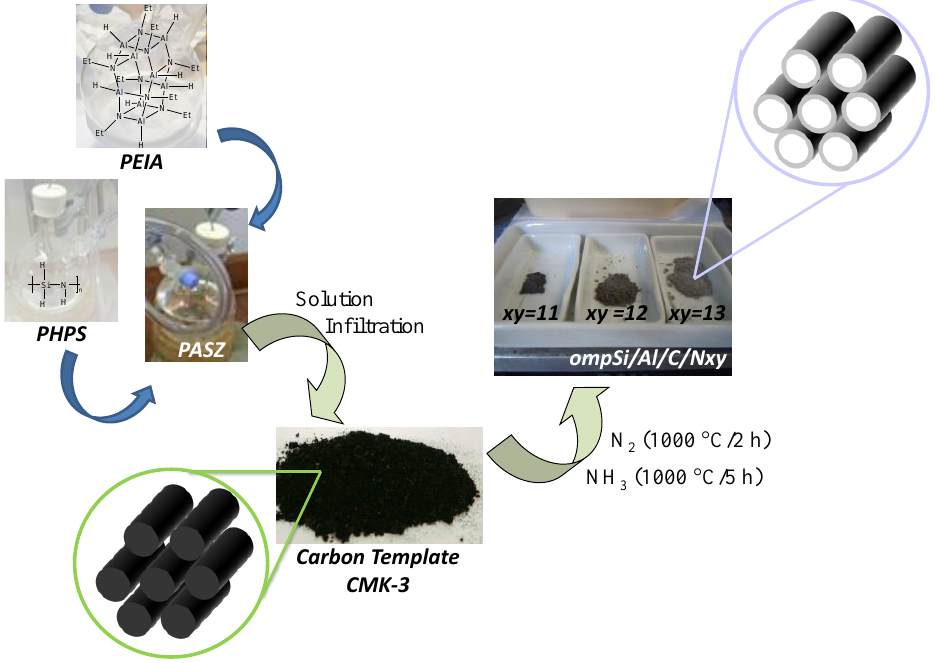
Figure 12. Procedure to prepare ordered mesoporous Si/Al/C/N ceramics by a polymer building block